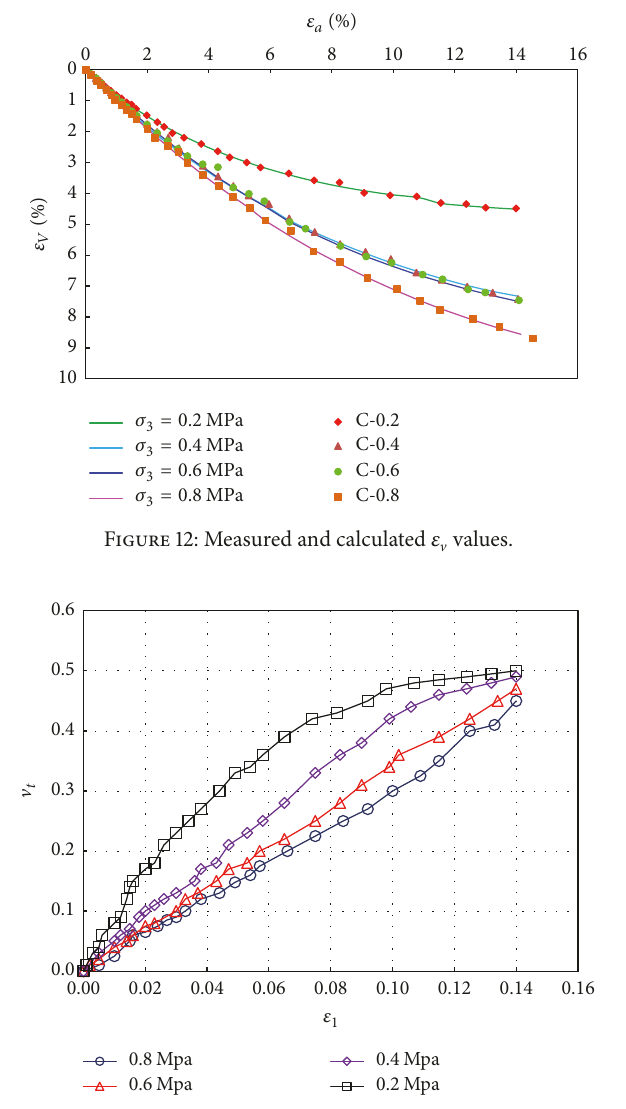
of the FLAC 3 D constitutive relation. The constitutive model library of FLAC 3 D was used in this process. The improved Duncan-Chang constitutive model was applied to numerical analysis of the slope of a mercury slag accumulation body and compared with the actual deformation and failure process of the slope to further verify the correctness and applicability of the